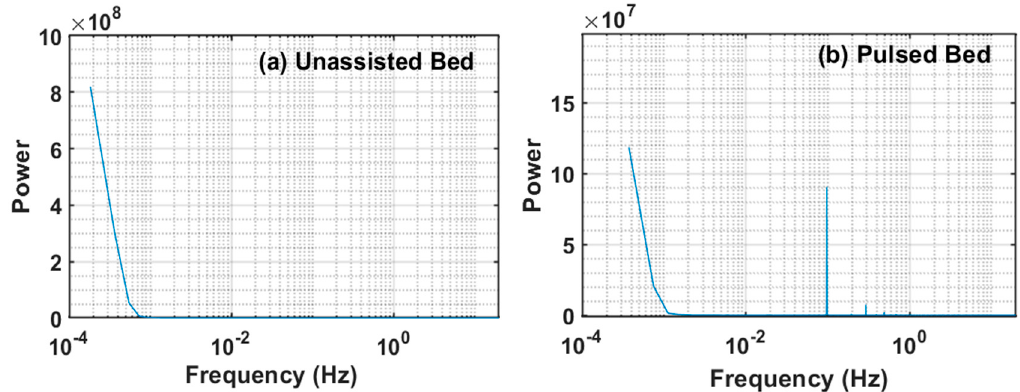
Figure 5. Power spectra of velocity during ( a ) unassisted and ( b ) pulsed assisted fluidization.